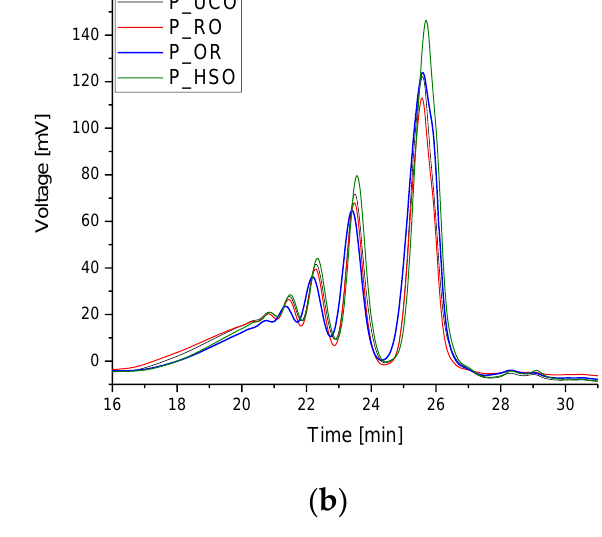
Figure 6. GPC chromatograms of oils ( a ) and bio-polyols ( b ).